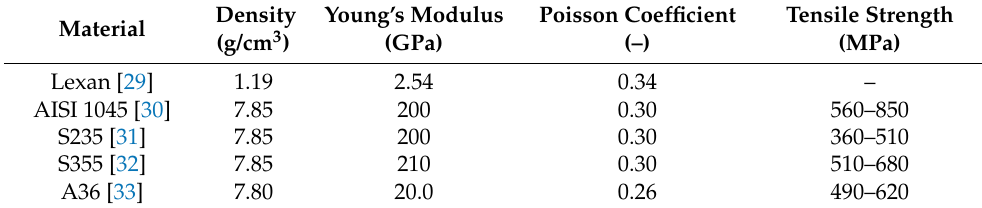
Table 2. Physical and mechanical properties of the studied materials.